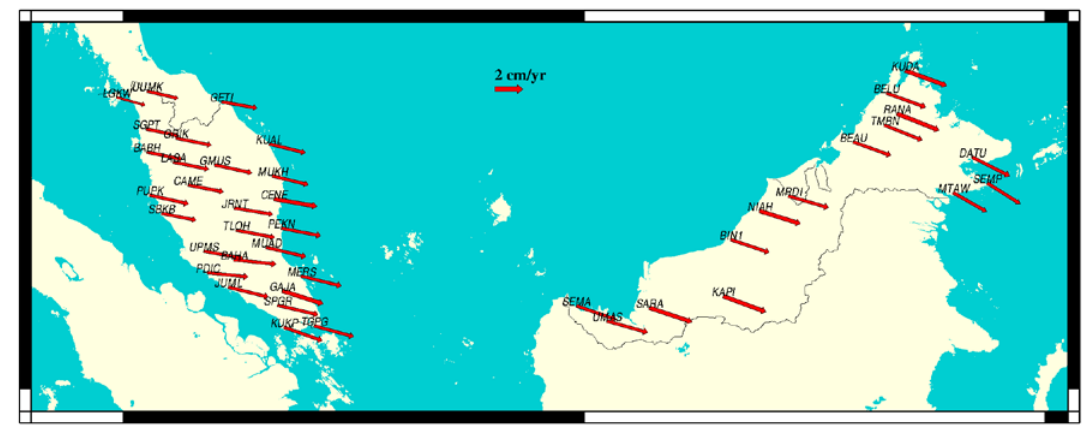
Figure 4. MyRTKnet velocity vector map for the Oct-2012 to 2014 period. Note that fewer stations are displayed as the station names and arrows will overlap one another